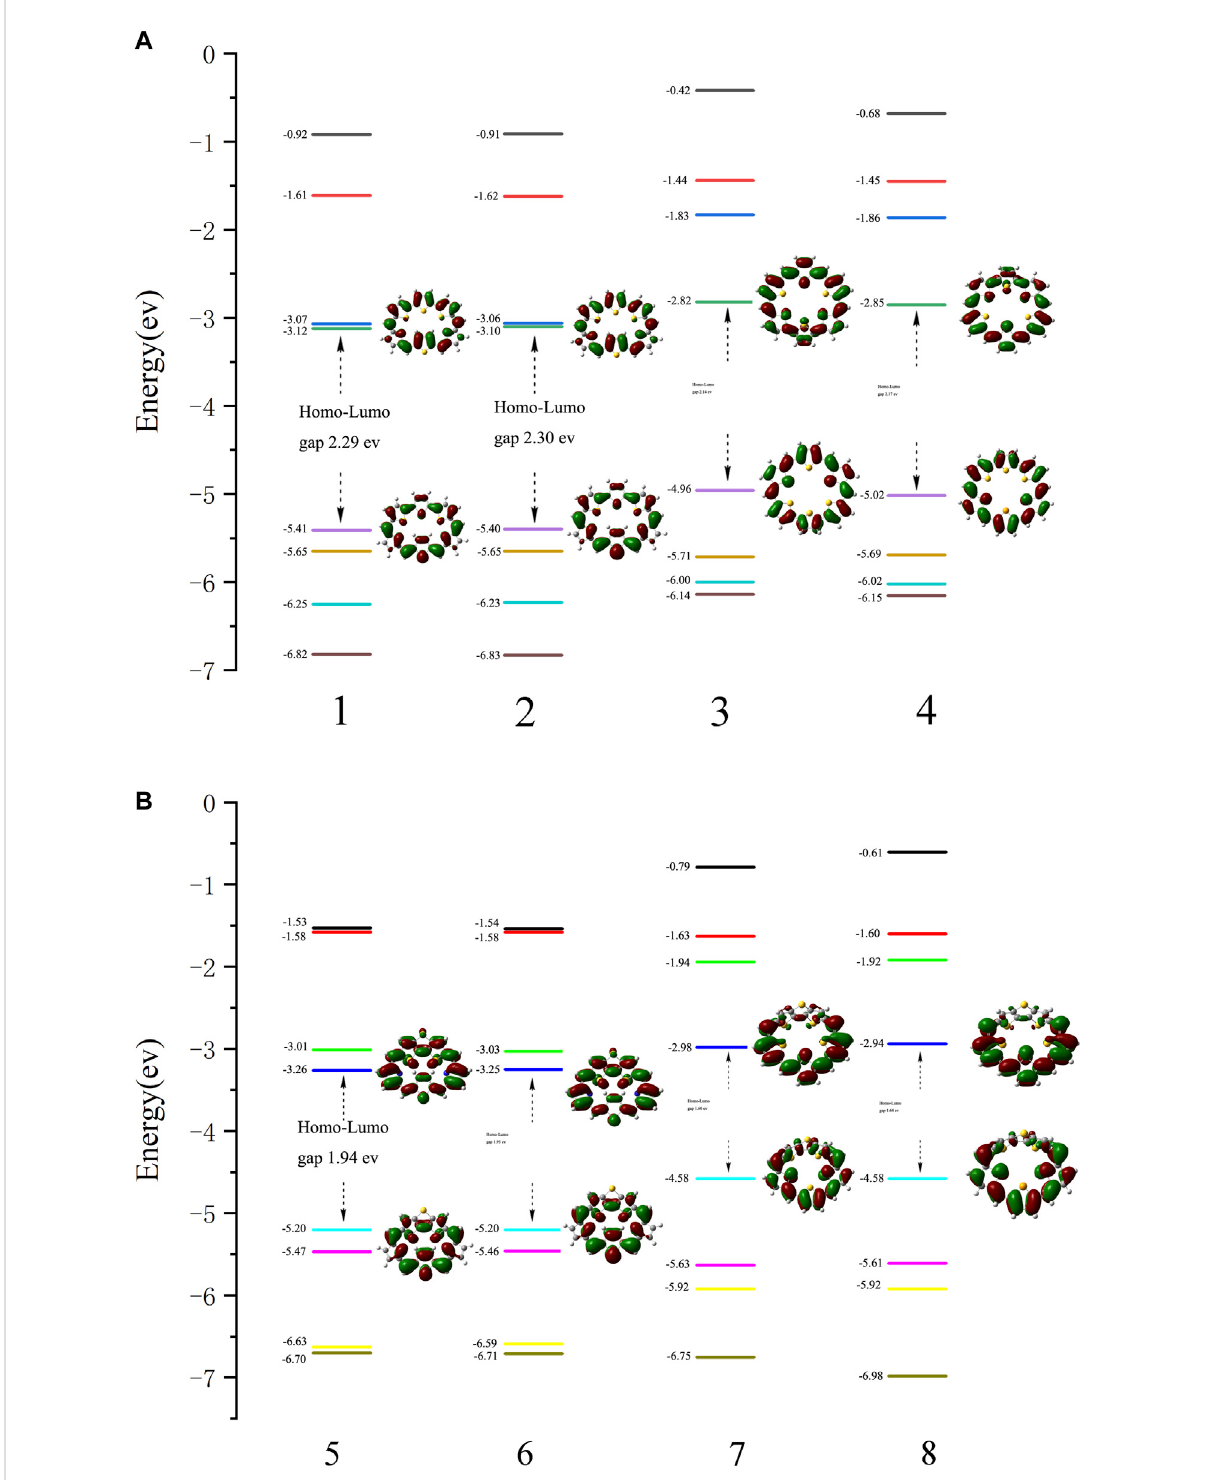
FIGURE 2 Molecular orbital distributions and diagrams of the frontier molecular orbitals (from HOMO-3 to LUMO+3) for (A) 1 , 2 , 3, and 4 and (B) 5 , 6 , 7, and 8